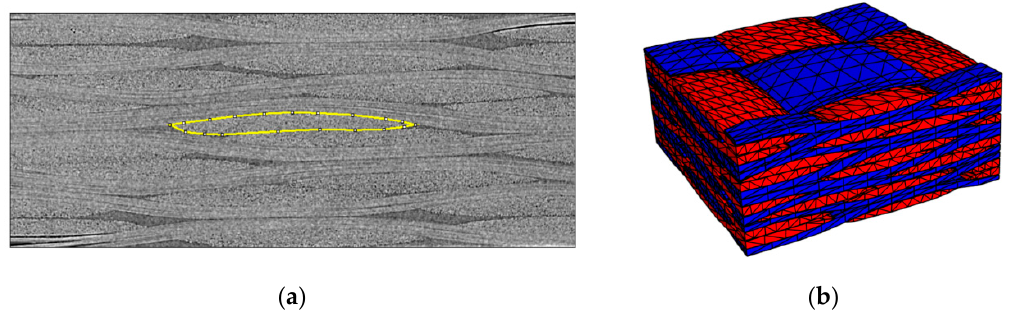
Figure 3. The manual segmentation steps: ( a ) Drawing a tow cross-section contour; ( b ) Tow surfaces from the cross-section contours.